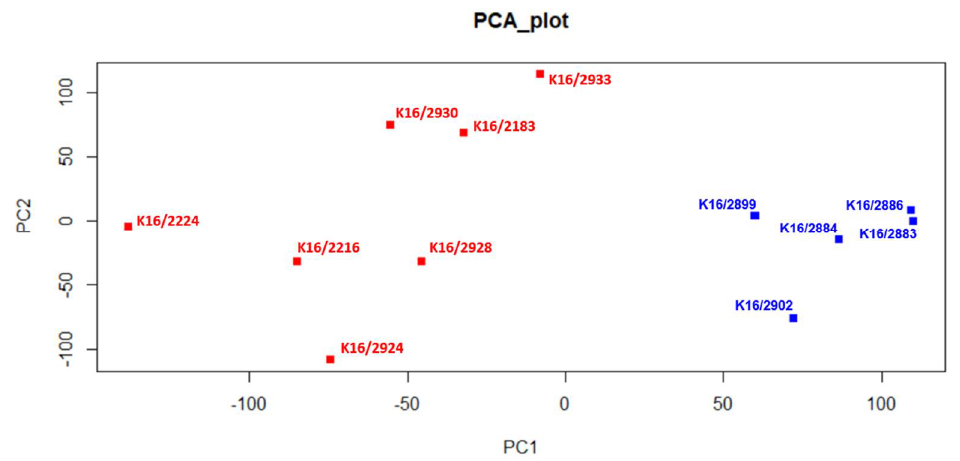
Figure 1. Principal component analysis (PCA). PedAML samples and healthy CB samples are colored in red and blue, respectively. Samples K16/2886 and K16/2883 refer to CD34+/CD38 − fractions isolated from healthy CB. Samples K16/2899, K16/2884, and K16/2902 refer to CD34+/CD38+ frac- tions isolated from healthy CB. Samples K16/2924, K16/2933, and K16/2930 refer to CD34+/CD38 − fractions isolated from pedAML patients. Samples K16/2224, K16/2216, K16/2928, and K16/2183 refer to CD34+/CD38+ fractions isolated from pedAML patients.